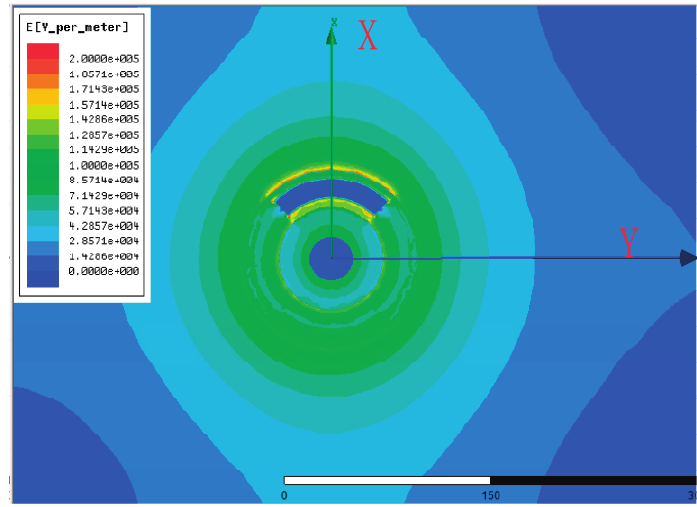
Figure 5. Electric field distribution surrounding the